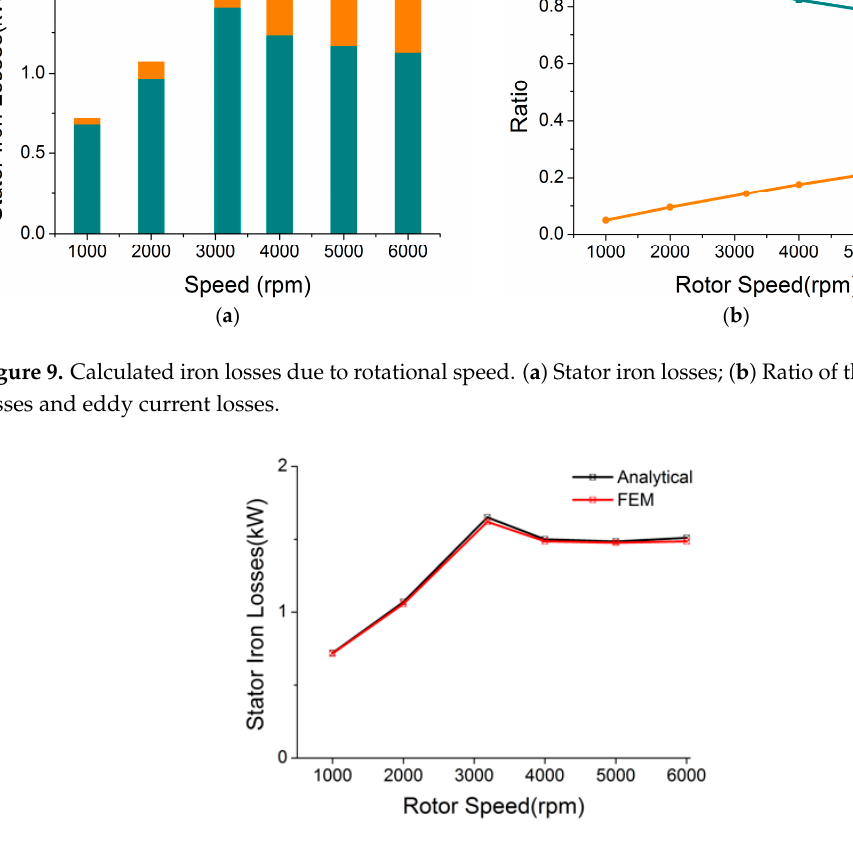
( b ) Figure 8. The magnetic flux density in the teeth and yoke under d-axis and q-axis current excitation. ( a ) Radial component of the flux density in stator teeth; ( b ) Tangential component of the flux density in stator yoke. 4.3. Stator Iron Losses According to Formulas (17) and (18), the stator iron losses can be calculated. The current excitation is varied with different amplitude and phase. Figure 9a shows calculated stator iron